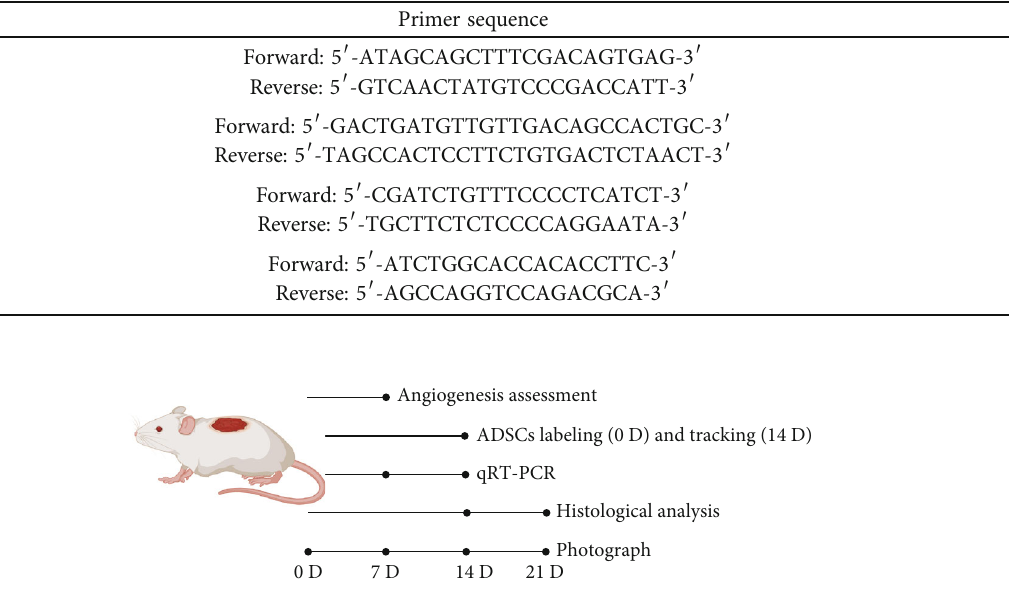
Figure 1: Flowchart depicting the experimental design for in vivo evaluation of ADM, N-ADSCs/ADM, and H-ADSCs/ADM in a diabetic wound rat